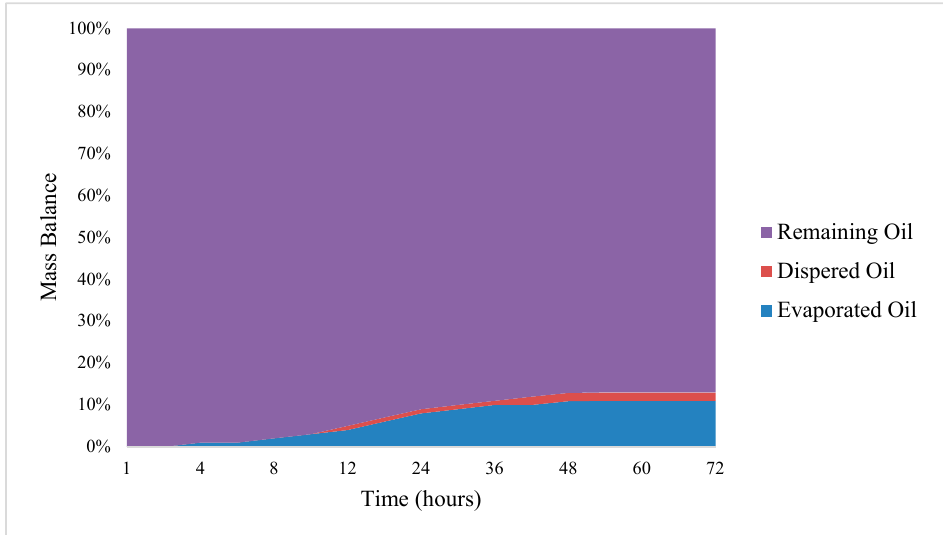
Figure 13. Automated Data Inquiry for Oil Spills (ADIOS, version 2.0) model’s predictions of evaporated, dispersed and remaining (surface) Intermediate Fuel Oil 380 (IFO-380) oil after three days of simulation. J. Mar. Sci. Eng. 2018 , 6 , x FOR PEER REVIEW